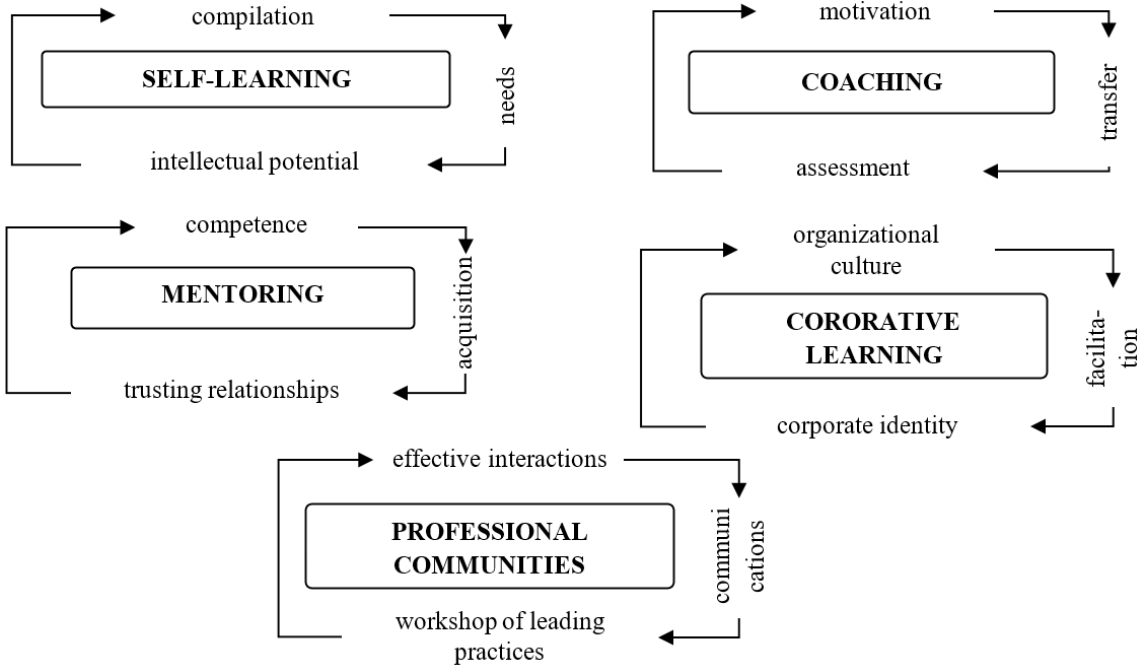
Figure 2. Toolkit of active forms in the development of creative entrepreneurial